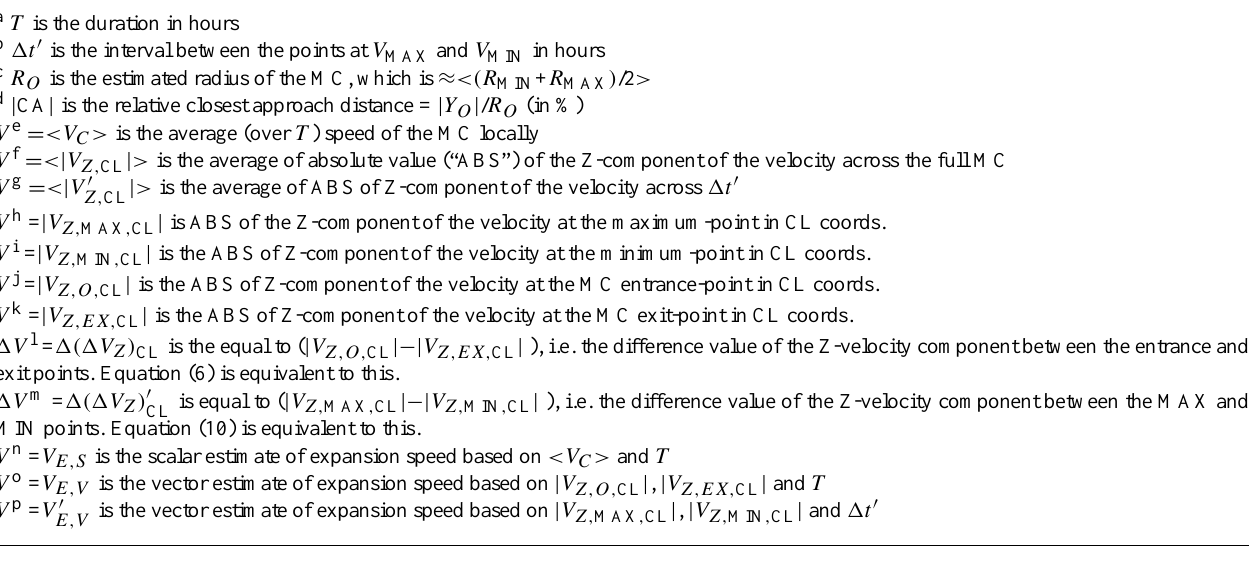
showing a c.c. of 0.85. E,V